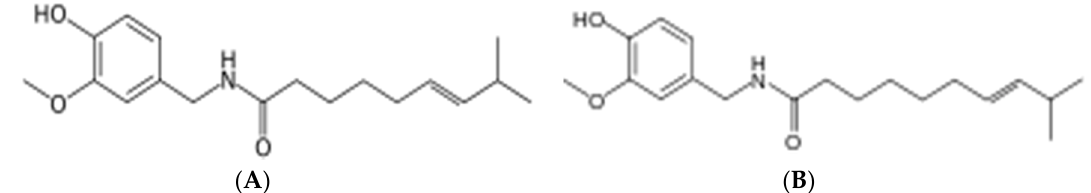
Figure 2. Mass scanning of red hot pepper methanolic extract, ( A ) capsaicin, and ( B ) homocapsaicin.